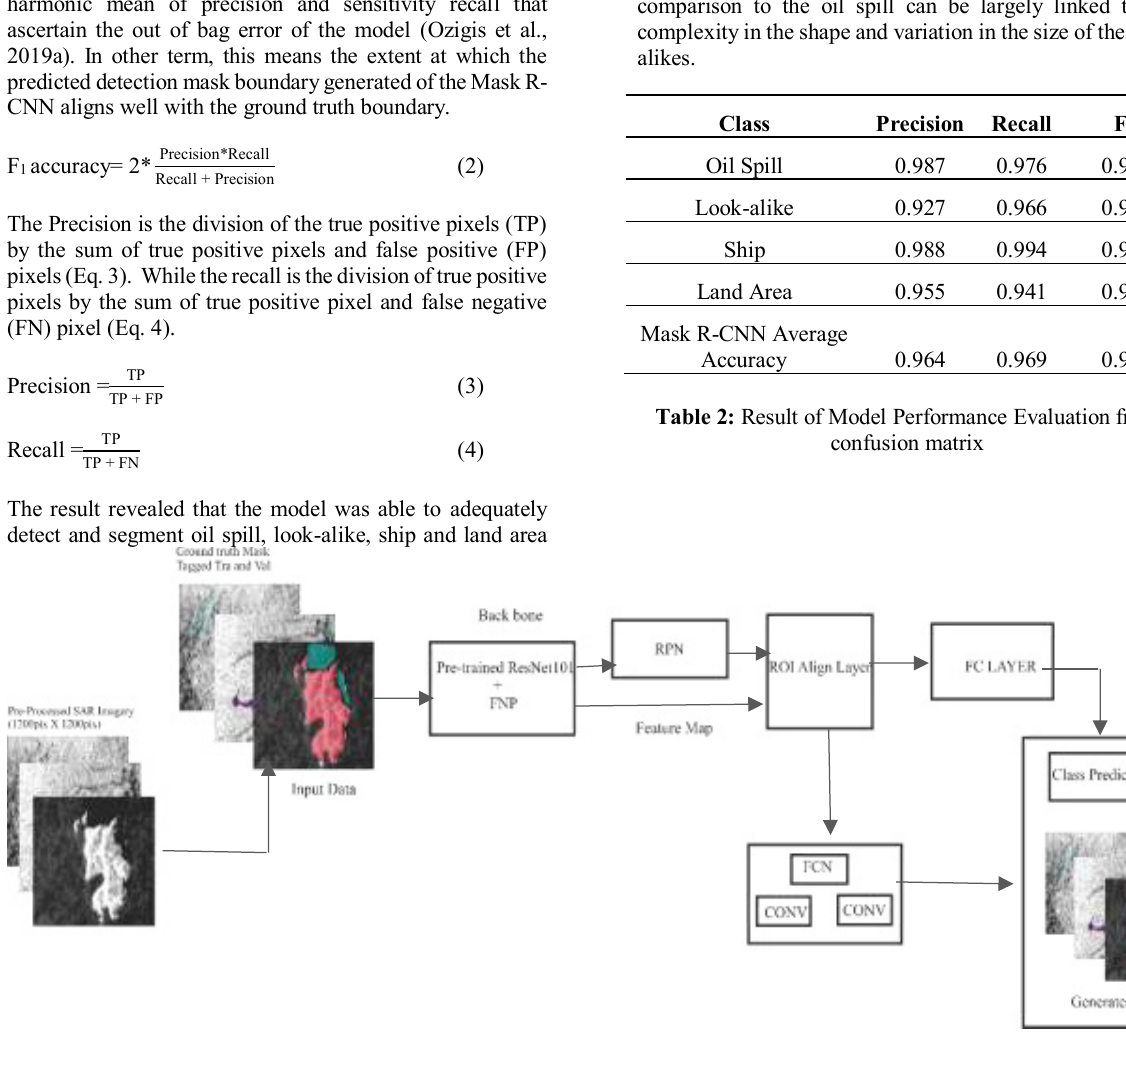
Figure 1 : General Architecture of the Deep Learning Oil Spill Detection and Segmentation Model with Mask